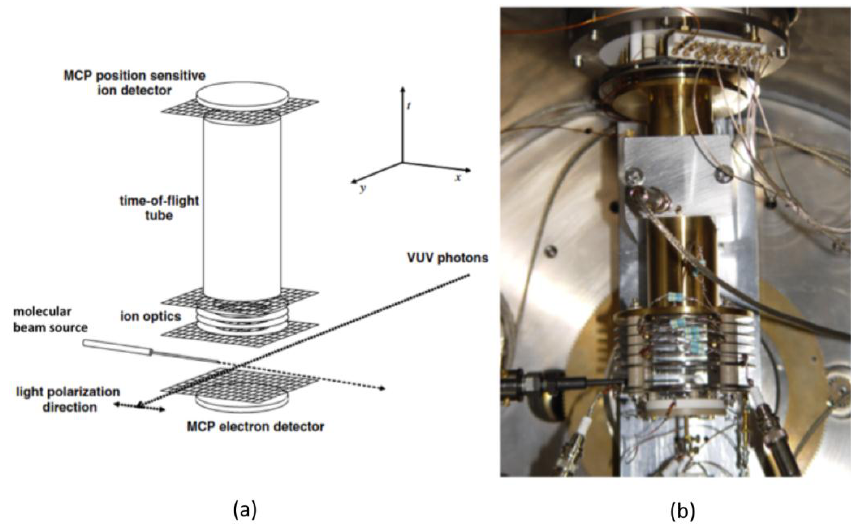
Figure 1. The electron-ion extraction and detection system used for the photoelectron-photoion coincidence measurements. ( a ) a scheme of the set-up and ( b ) a picture of such a device. The molecular beam of CO 2 , N 2 O and C 2 H 2 crosses at right angles the VUV light beam, having the light polarization vector parallel to the synchrotron ring plane and perpendicular to the time-of-flight